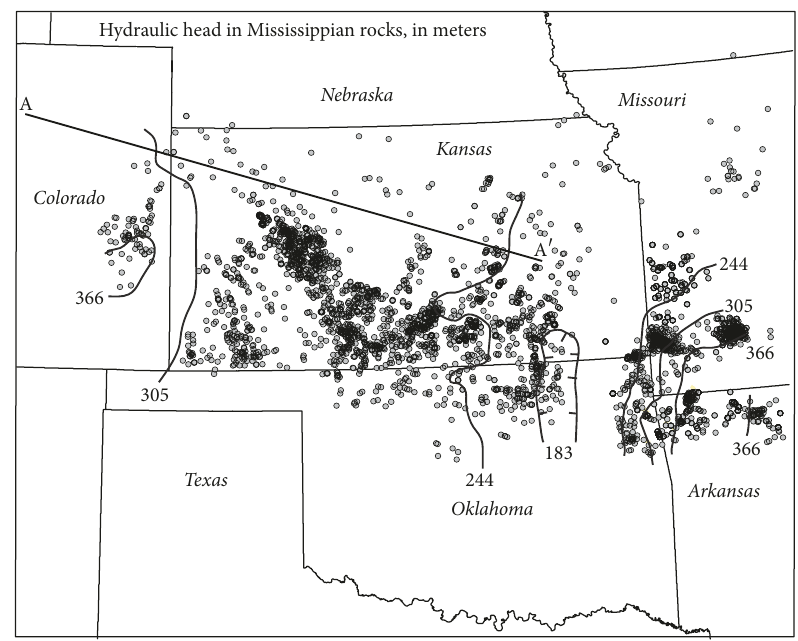
Figure 11: Map of potentiometric surface (hydraulic head contour lines in meters) in rocks of Mississippian age, after Nelson et al. ([7], Figure 14E). Hydraulic head decreases from about 366 m in water wells in Missouri and Arkansas to less than 183 m in oil and gas wells in eastern Oklahoma and then increases westward to values greater than 366 m in eastern Colorado. Dots represent well control. Control data for the hydrologic model were taken along 800 km line A-A 󸀠 .